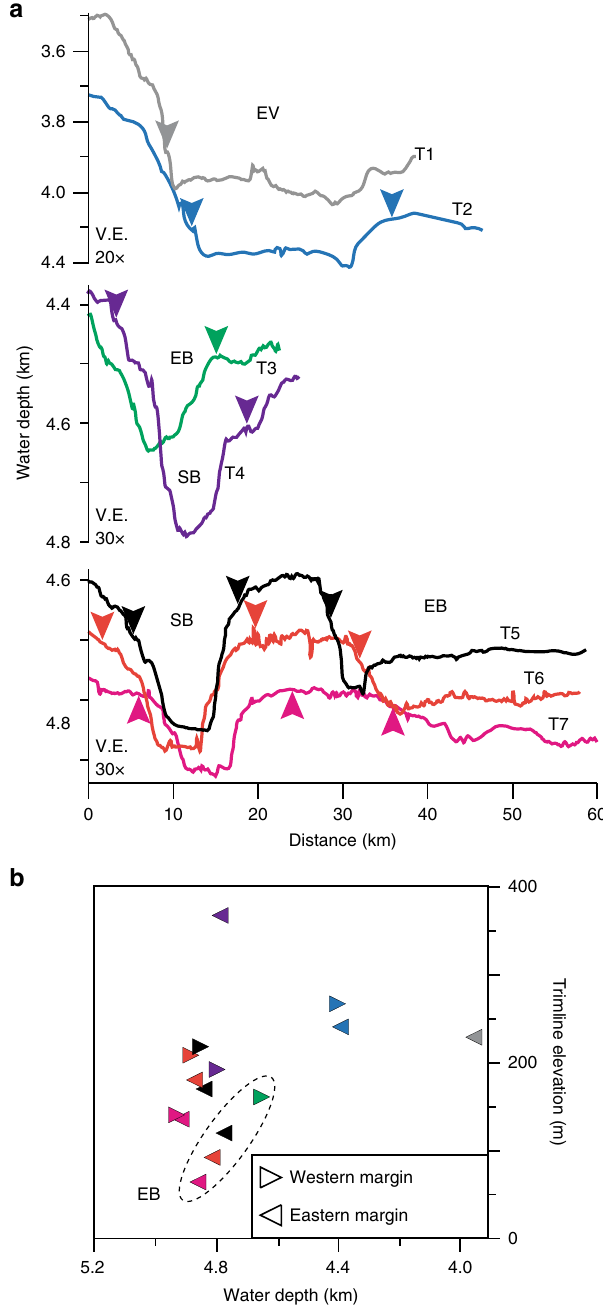
Fig. 3 Cross-section topographic pro fi les and trimline elevations. a Channel cross-section topographic pro fi les T1 – T9 with erosion trimlines marked (arrows) from the backscatter bathymetry (Fig. 2). b Plot showing trimline elevations from channel fl oor bathymetry (colour coded to T1 – T9 pro fi les). EV Eastern Valley, EB East Branch, SB South Branch (see Fig. the acceleration due to gravity; Q , the channel-bend radius; dH/ dr, the slope of the upper interface of the fl ow along the radial direction (dH, the height difference between inner-bend and outer bend trimline, dr, the width of the channel); and f , Coriolis acceleration ( f = 2 Ω sin Φ , Φ = 42°N, Ω is the angular speed of the Earth ’ s spin). Equations (1) and (2) yield bulk sediment concentrations for the fl ow between 0.5 – 4.8% through South Branch, and 0.5 – 10.2% through East Branch (Fig. 4). Flow concentration progressively